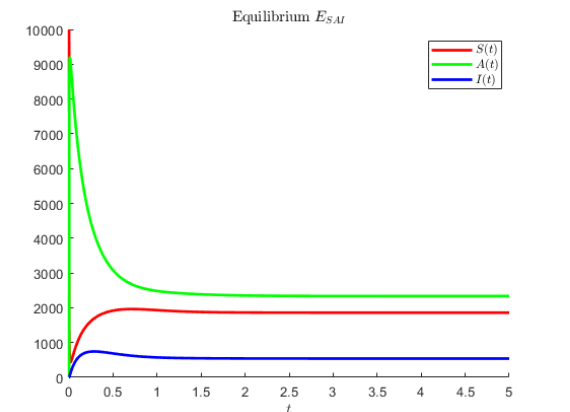
Figure 2. Coexistence equilibrium for model (1) obtained with parameter values (53), (51) and initial conditions (50).